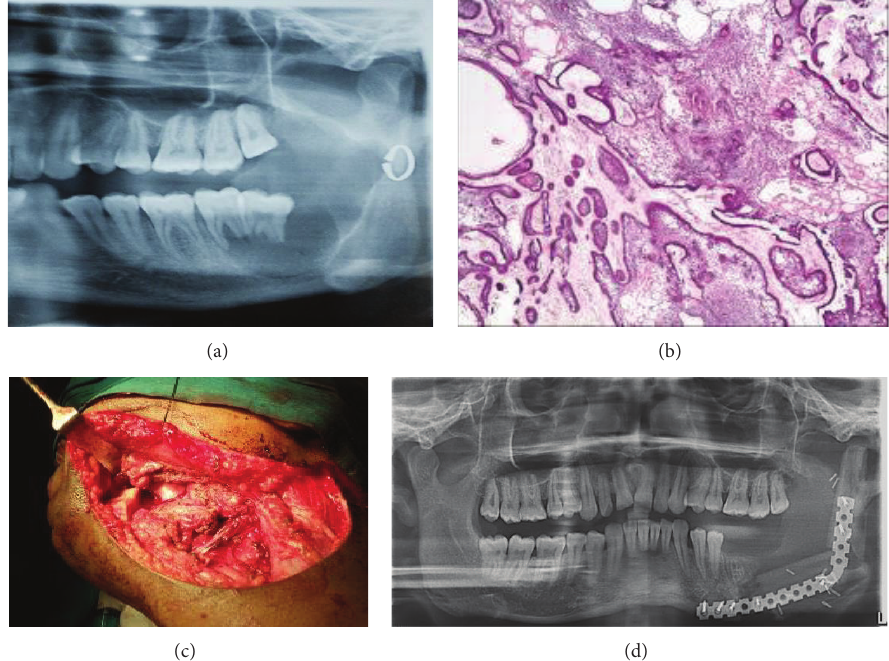
Figure 3: (a) Preoperative OPG. (b) Histopathologic examination. (c) Intraoperative. (d) Postoperative. Fibula with reconstruction plate. maxillectomy was done under general anaesthesia (Table